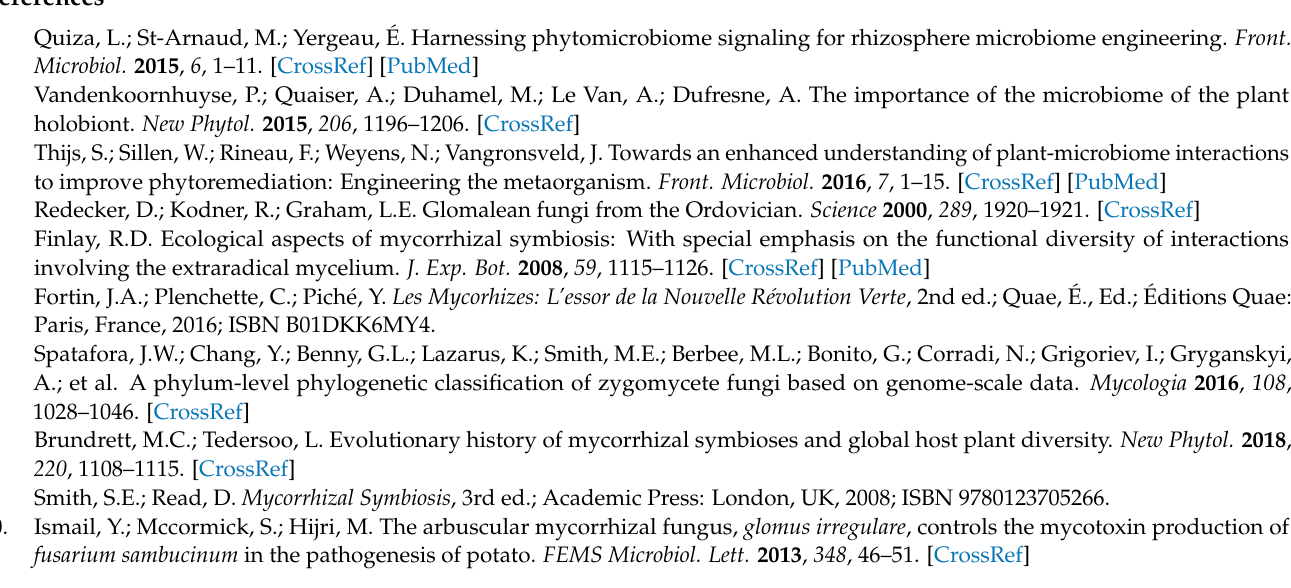
archaeal ASVs, Figure S5: Boxplot of distance to centroid, Figure S6: MA-plots showing fold difference in the normalized count abundance ASVs, Figure S7: Most abundant ASVs showing significant differential abundances between two sample groups, Table S1: Tukey multiple comparisons of mean beta-dispersions for each group